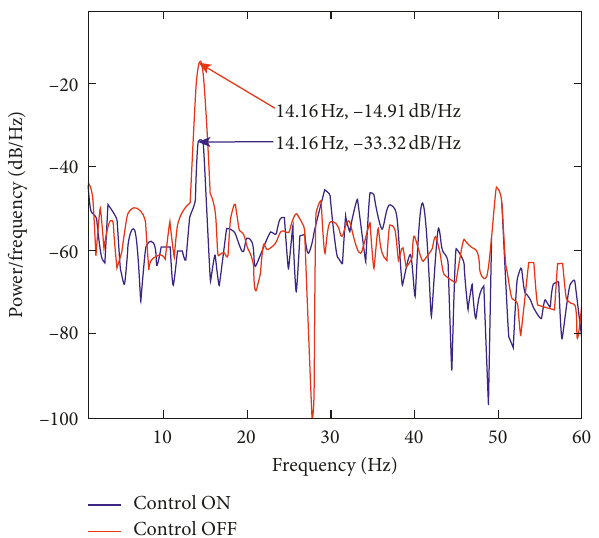
Figure 9: Comparison of power spectrum with NNPID control on/off.